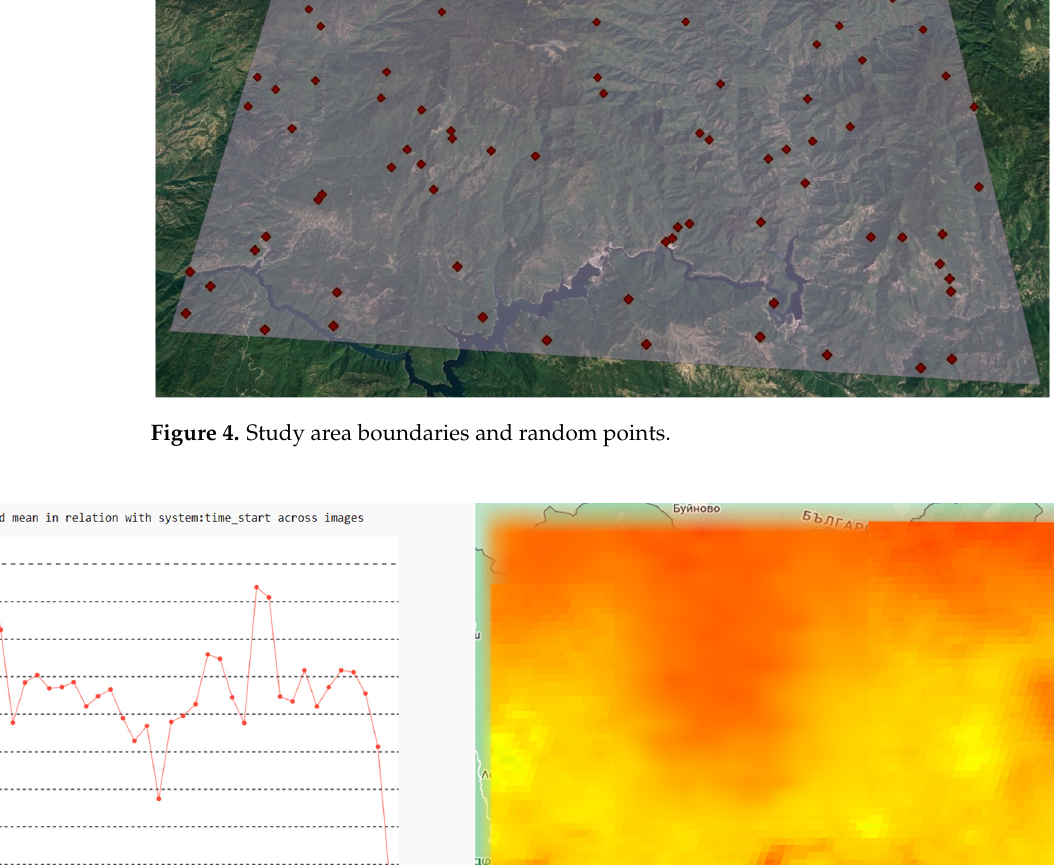
Figure 4. Study area boundaries and random points.